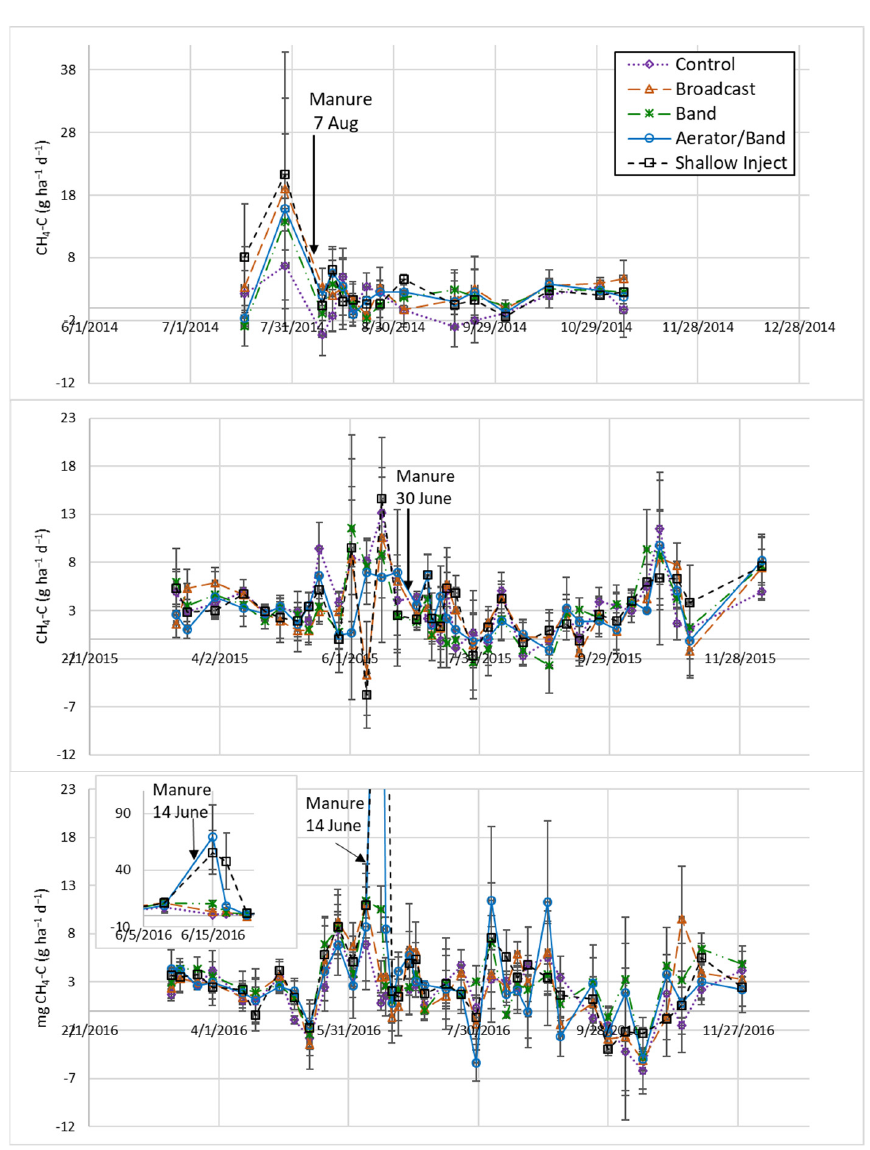
Figure 6. Mean methane (CH 4 ) fluxes by manure application treatment for 2014 ( top ), 2015 ( center ), and 2016 ( bottom ).